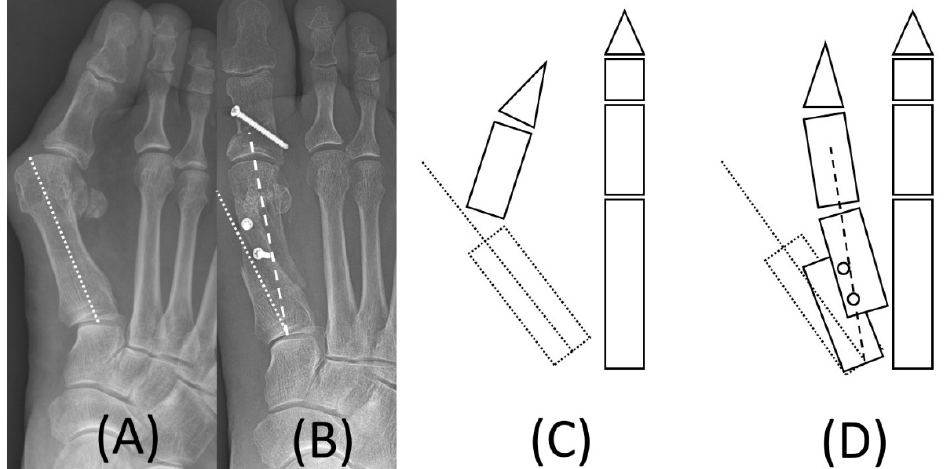
Figure 2. Mechanical axis of the first metatarsal in pre- and postoperative plain radiographs. Both mechanical and anatomical axes of the first metatarsal (dot line) are the same in pre-operative plain radiograph ( A ); The postoperative mechanical axis of the first metatarsal (dash line) is a connecting line to the base and articular center of the first metatarsal, which are laterally angulated compared to the pre-operative axis ( B ); In the schematic drawing, the postoperative mechanical axis (dash line) was corrected laterally ( D ) compared to the pre-operative first metatarsal (dot line) axis ( C ).